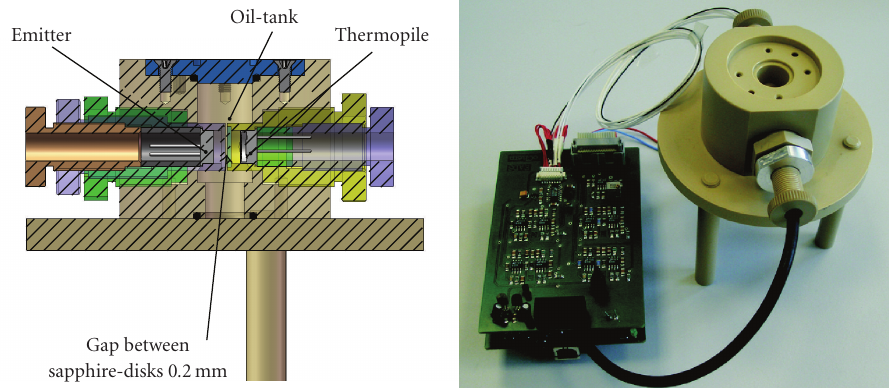
Figure 9: IR sensor system as integrated into a piece of piping: (left) Schematics, (right) realised sensor